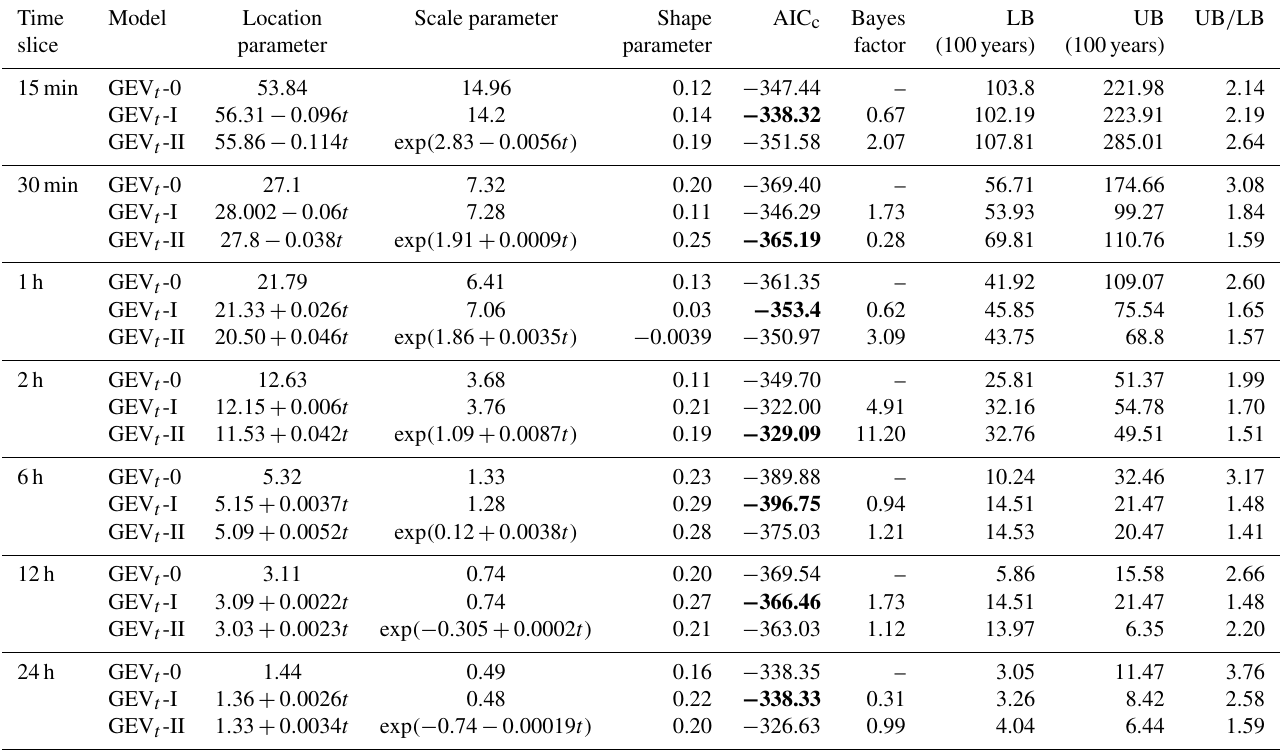
Table 3. Performance of stationary and nonstationary models for Hamilton Airport. Time